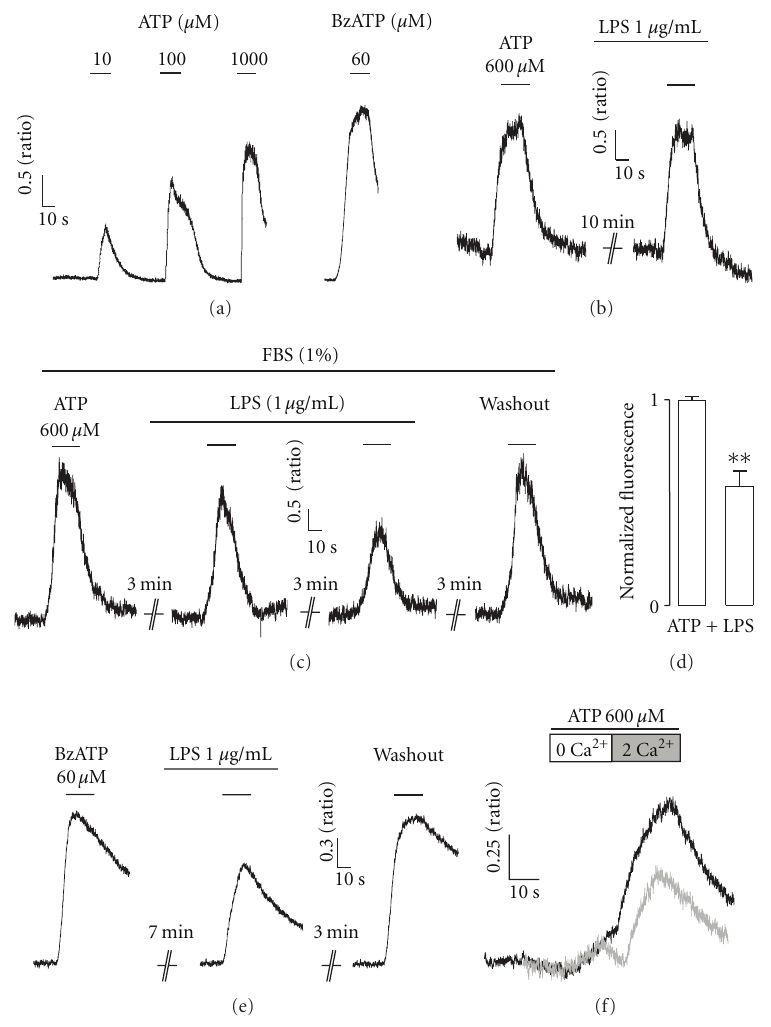
Figure 3: LPS inhibits ATP-induced intracellular calcium increases in P2X7R-HEK293 cells. (a) Representative tracings of a single cell responding to di ff erent ATP concentrations and to 60 μ M of the P2X7R-agonist BzATP. (b) Representative recordings showing the lack of e ff ects of LPS in the absence of FBS. (c) Representative recordings showing the time dependent inhibition of ATP-induced calcium transients induced by 1 μ g/mL LPS, in the presence of 1% FBS. (d) Summary of the inhibition induced by 7min of LPS preapplication ( P < 0 . 01, n = 4). (e) Recordings of calcium increases induced by 60 μ M BzATP and inhibition by the pre-application of LPS. Similar results were observed in 3 di ff erent cells. (f) Recordings in the absence of extracellular calcium, in the absence (black tracing), and in the presence (gray tracing) of LPS (preapplied for